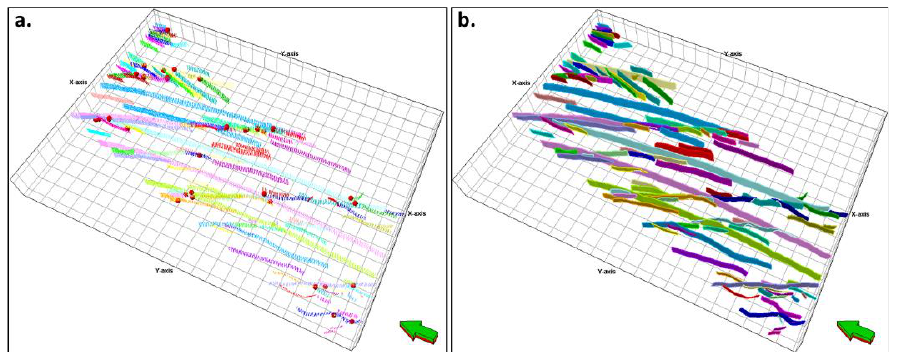
Figure 10. Fault sticks from seismic interpretation (colored sticks) and fault break points (red points) identified in wells ( a ) and fault planes (colored bands) finally adopted in the structural framework ( b ). The red points and red lines attached on the fault sticks indicate probable unreasonable fault contacts. After multiple fault contact test – seismic iterations, the unreasonable fault contacts are eliminated. The green arrow indicates the north direction.